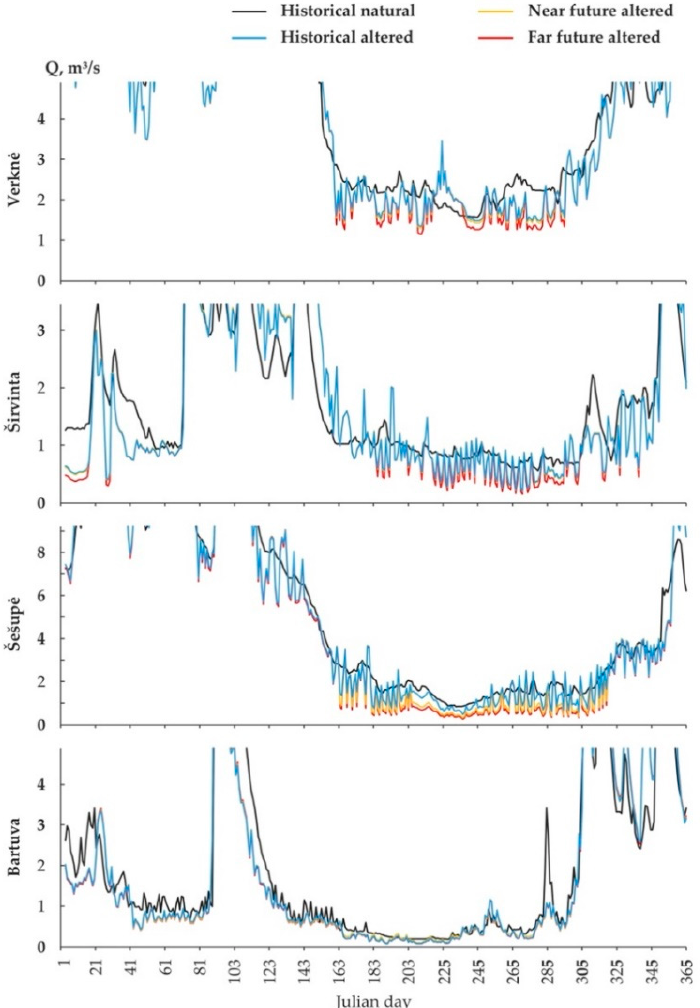
Figure 5. Hydrological scenarios for the Verkn ė , Širvinta, Šešup ė and Bartuva rivers for the historical reference and altered conditions, and under climate change for the near and far future (ensemble of RCP scenarios).